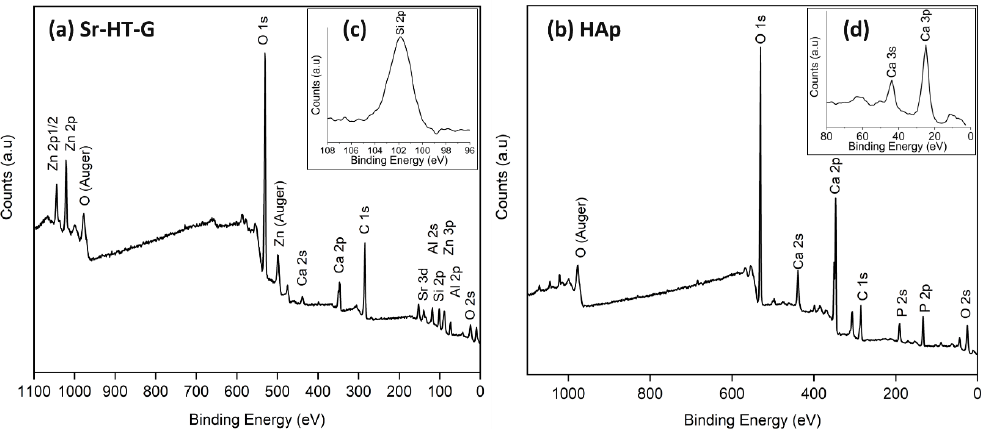
Figure 3. XPS analysis of Sr–HT–G coating ( a ) and HAp coating ( b ). The peaks of Si 2 p ( c ), Ca 3 i and Ca 3 p ( d ).